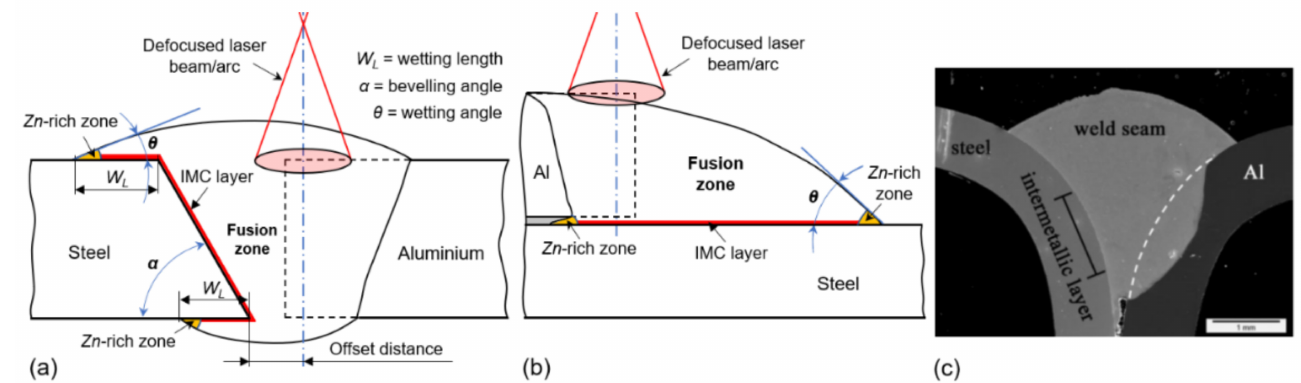
Figure 7. ( a ) Laser-assisted arc welding or laser welding–brazing for thin components [72] and ( b ) keyhole laser beam welding for thicker components [80].